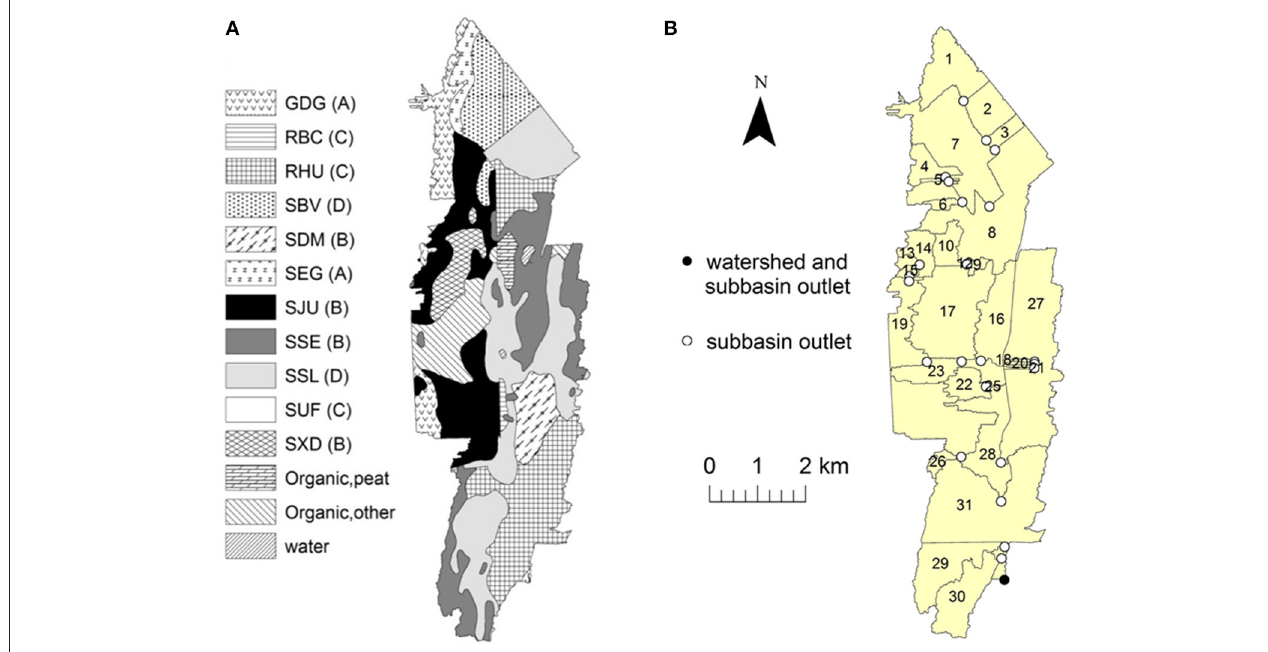
FIGURE 1 | The Ewing subwatershed of the Pike River watershed in southern Quebec, Canada showing (A) the soils (and hydrologic soil groups in brackets), described in Table 1 . (B) Location of outlets of the 31 subbasins and the watershed in the model watershed setup.